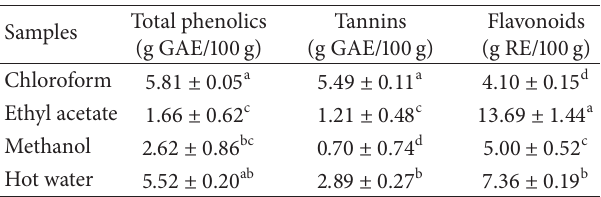
Table 3: Total phenols, flavonoids, and tannin content of leaves of C . dipsaceus .